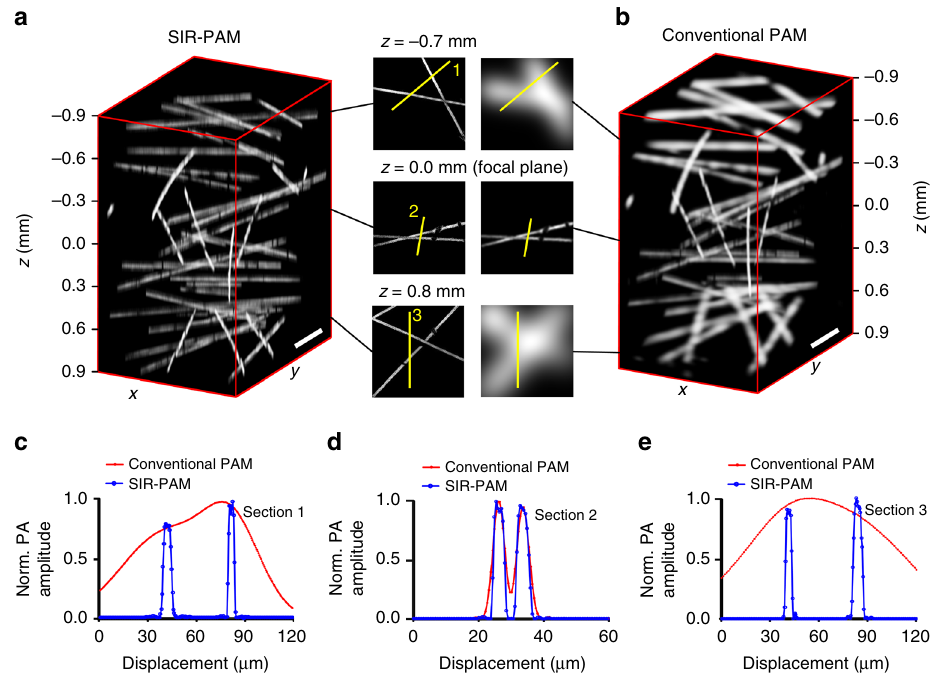
Fig. 4 Volumetric imaging of spatially distributed carbon fi bers. a Volume-rendered image of a 3D object reconstructed by SIR-PAM, showing spatially invariant resolution. b Image of the same region as in a obtained by conventional PAM with decreasing lateral resolution away from the focal plane. Three pairs of en face image slices were taken at imaging depths of – 0.7, 0.0, and 0.8 mm. The focal plane is located at z = 0.0 mm. c − e Corresponding line pro fi les across the carbon fi bers shown to compare the imaging quality of the two systems. Scale bars , 150 µ m